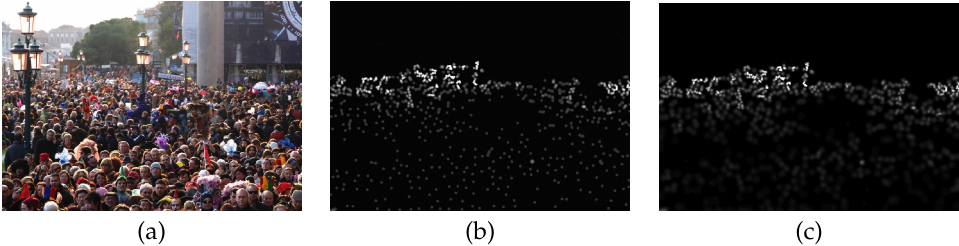
Figure 9. The density maps for the image ( a ) shown with a fixed sigma ( b ), and with the geometry adaptive sigma ( c